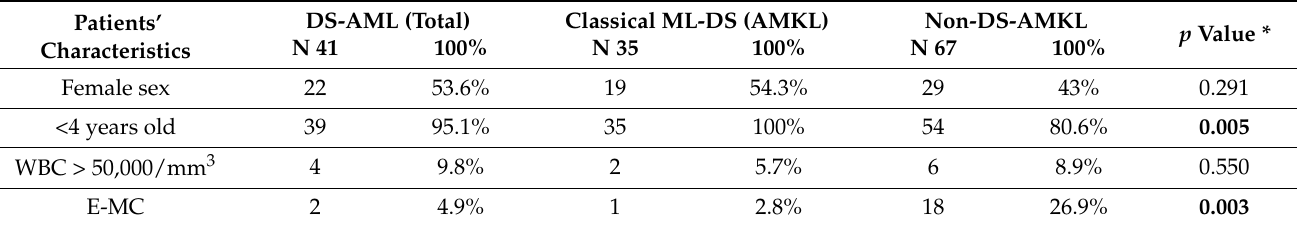
Table 1. Patients clinical, biological and demographic characterization of Down Syndrome–Acute Myeloid Leukemia